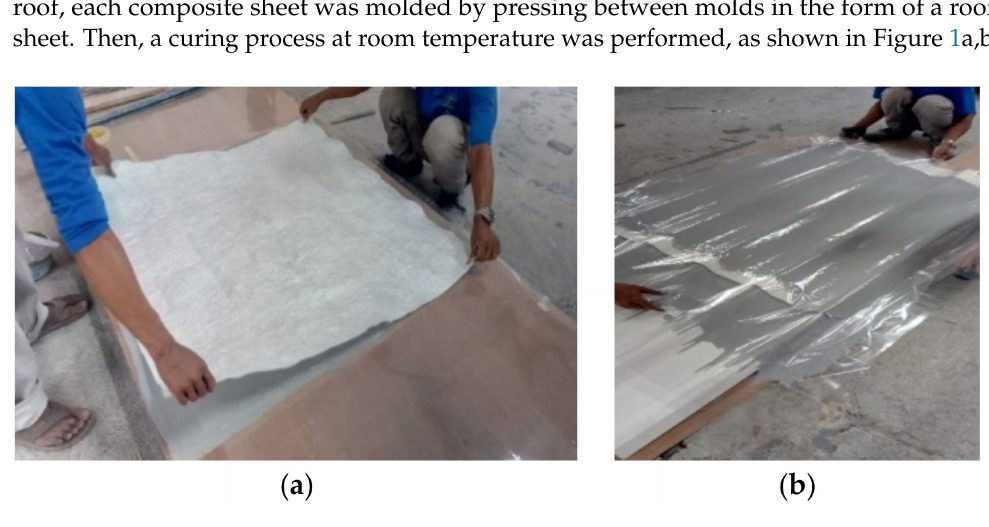
Figure 1. ( a , b ) Layering and molding of a GFRP composite